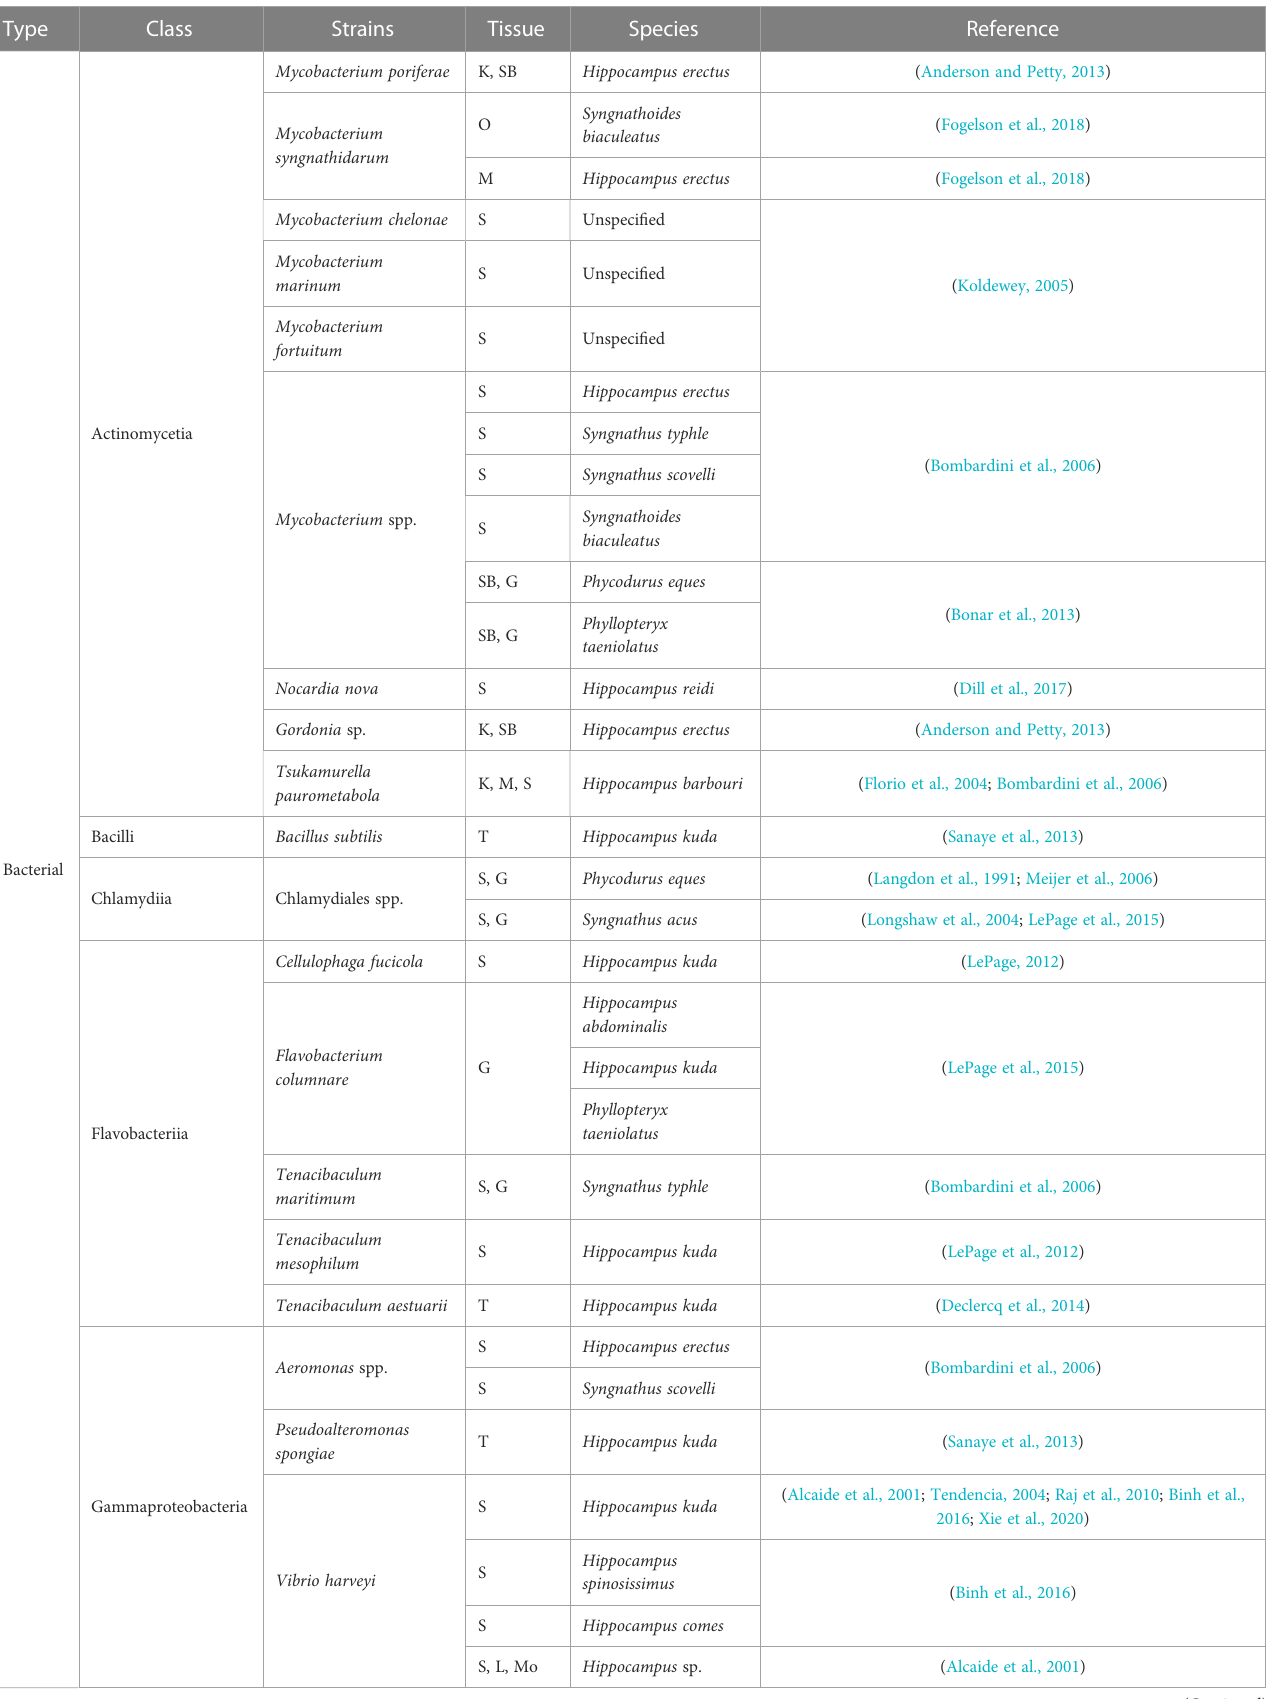
TABLE 1 Harmful pathogens identi fi ed in aquaria bred or raised syngnathid fi